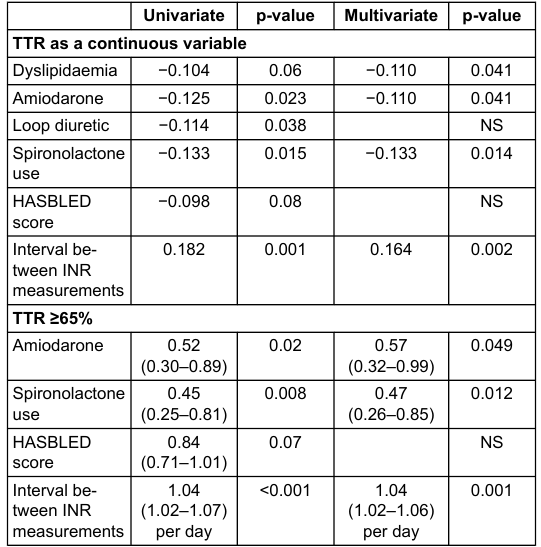
Table 3: Predictors of high time in therapeutic range (TTR).